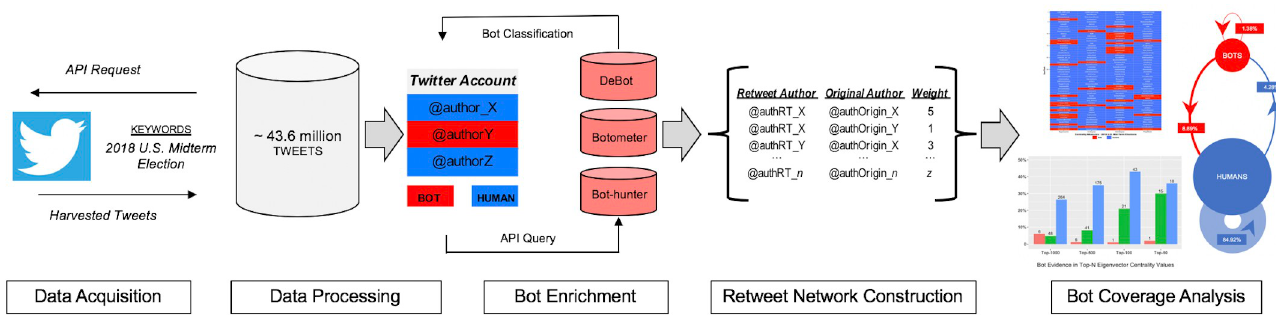
Fig 1. Social bot analysis framework employing multiple bot detection platforms. The framework enables the application of ensemble analysis methods to determine the prevalence and relative importance of social bots within Twitter conversations discussing the 2018 U.S. midterm elections.